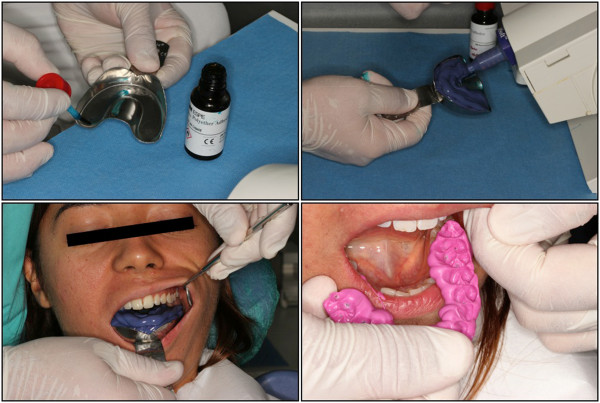
Conventional impression technique. A) Adhesive application, B) Impression tray loading, C) Upper and lower arches impression, D) Bite registration.